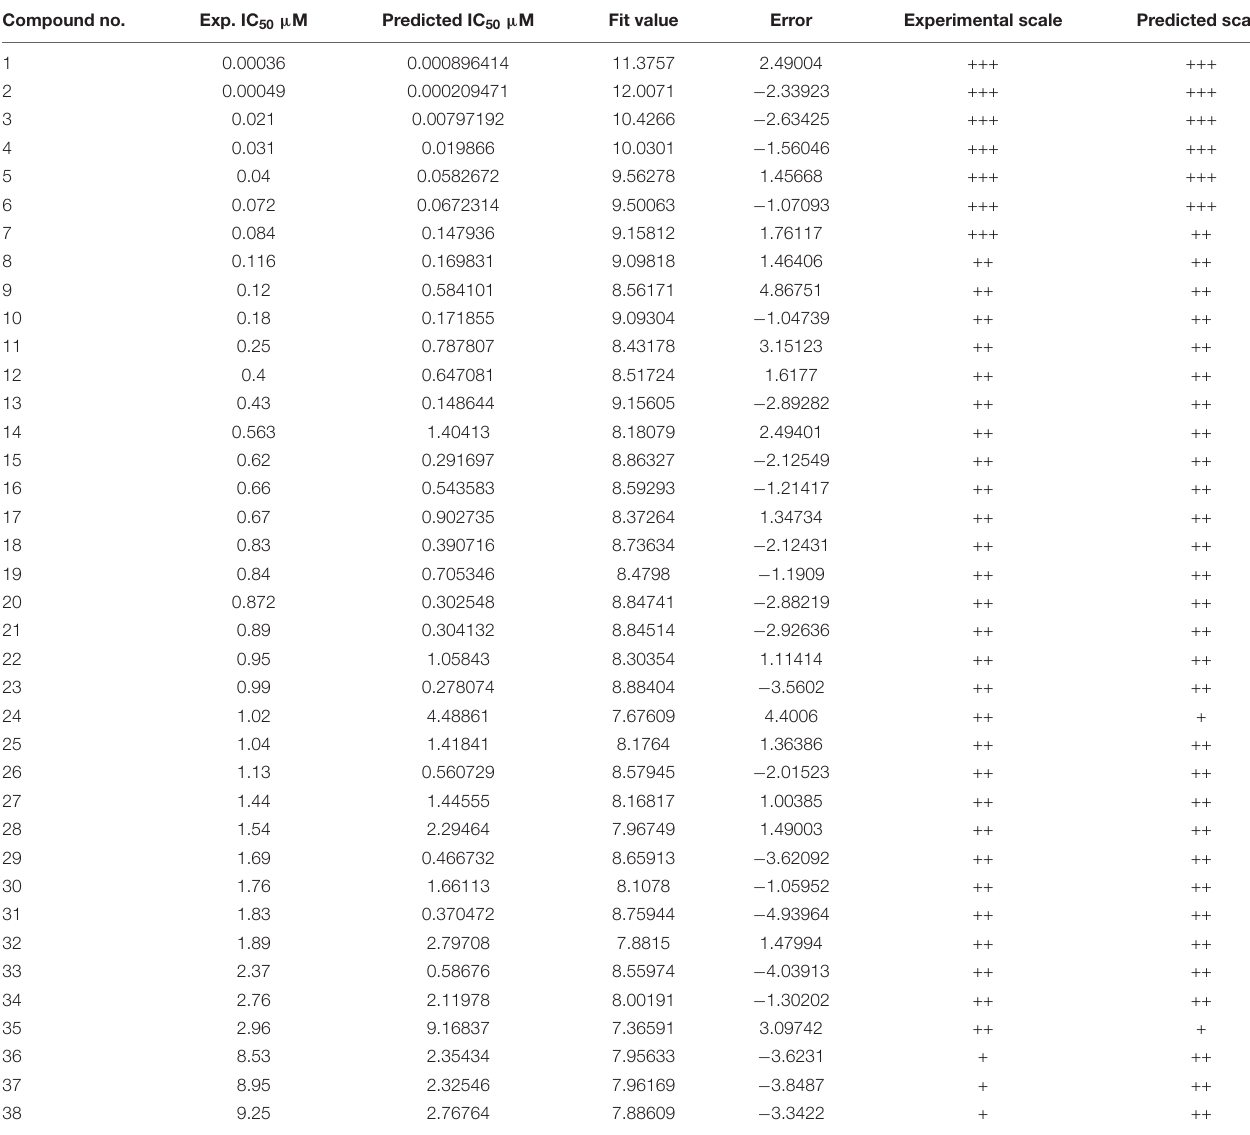
TABLE 2 | Actual and estimated efficacy of the test set molecules based on the Hypogen1 model. Compound